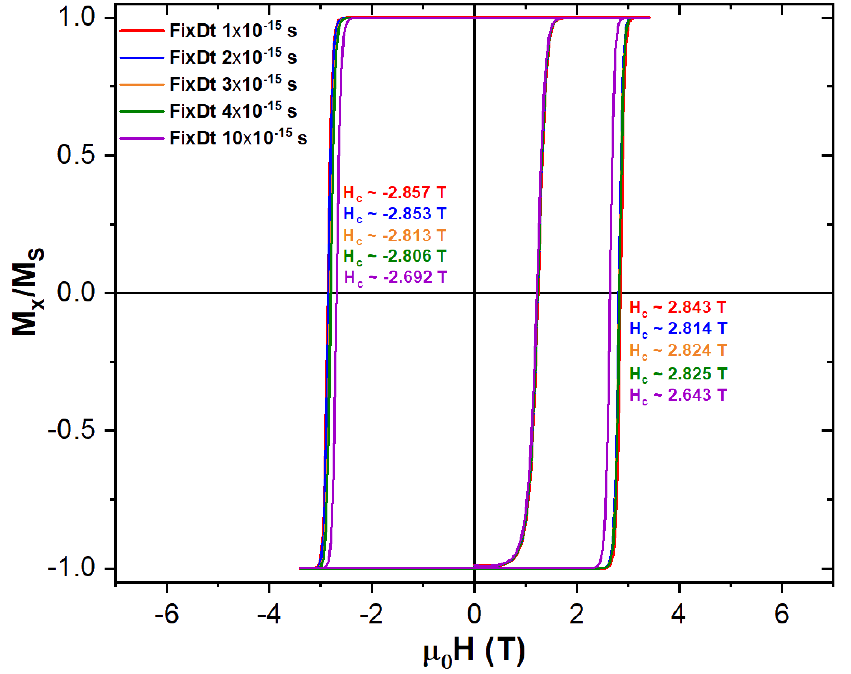
Figure 3. Coercivity ( H c ) variation with the computational time step, FixDt, at 0 K. Smaller FixDt values correspond to a higher numerical precision, but at the cost of significantly longer simulation